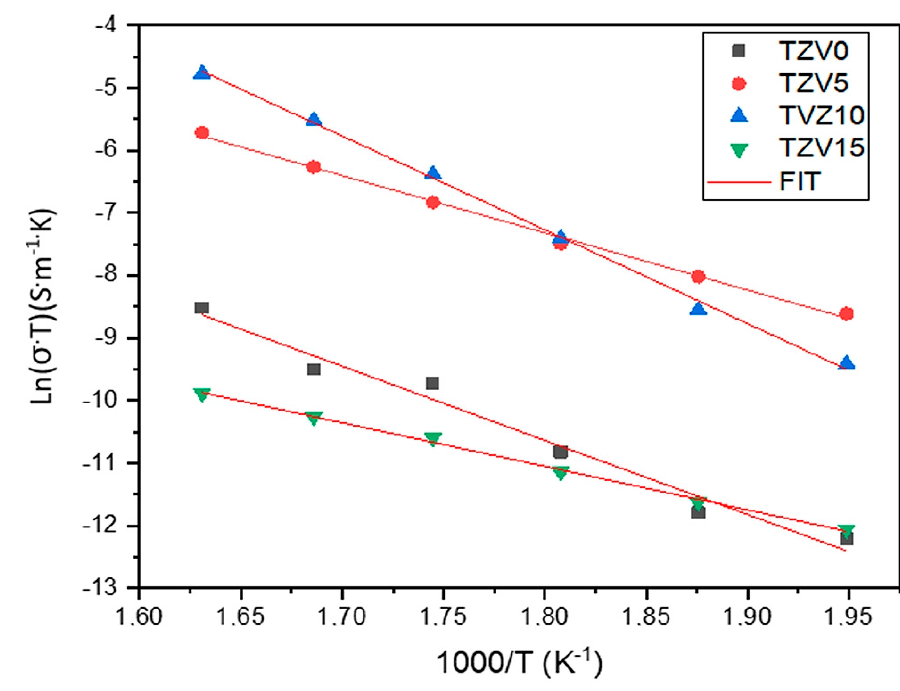
Figure 8. Arrhenius plots of electric dc conductivity of the TZV